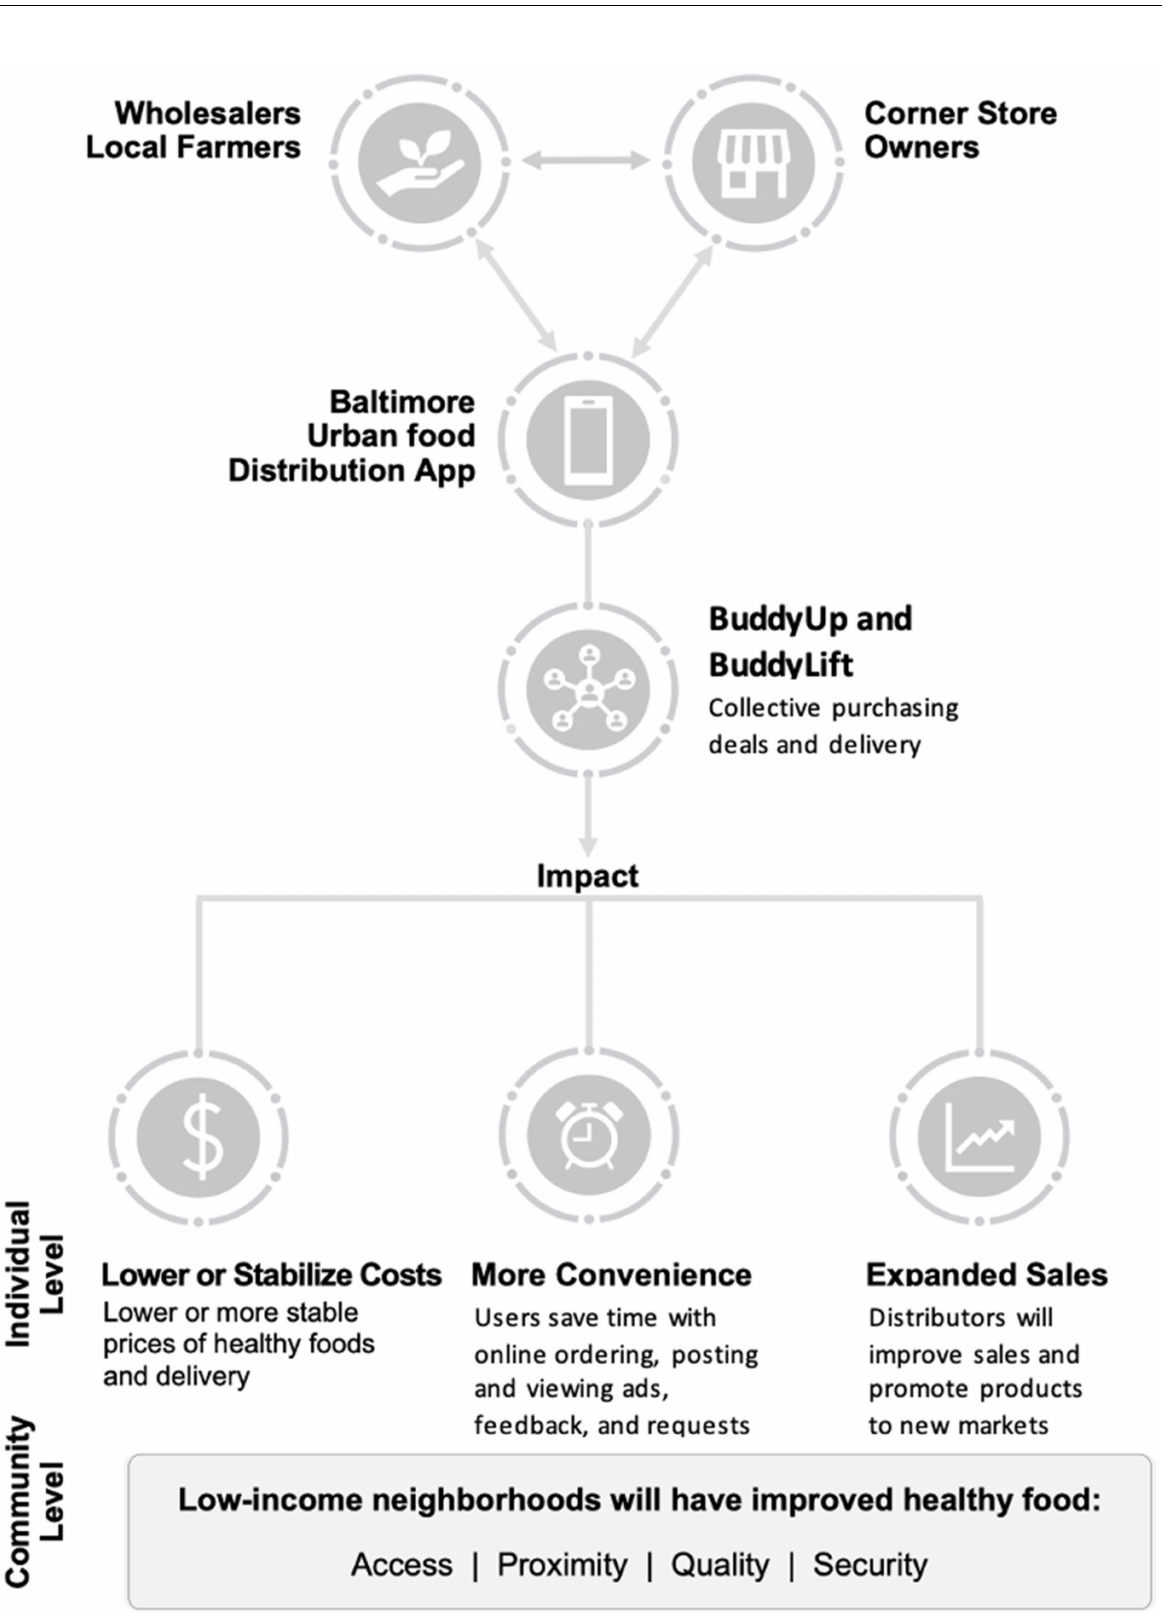
Figure 1. Baltimore Urban food Distribution (BUD) app conceptual